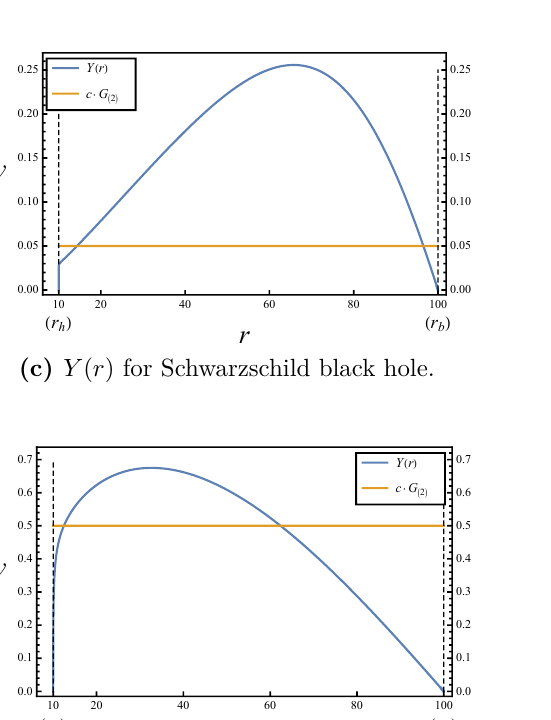
(b) Y ( r ) for Weyl-related Witten (CGHS) black hole.